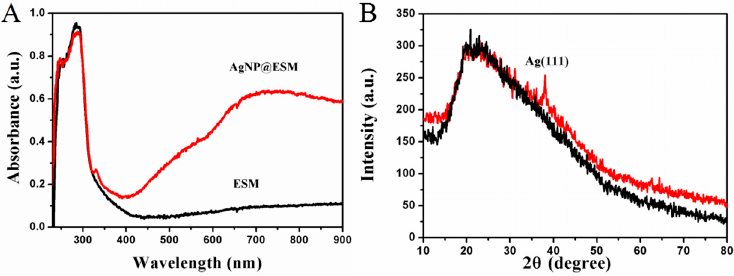
Figure 3. UV-vis diffuse reflectance spectra ( A ) and XRD pattern ( B ) of pristine ESM and AgNP@ESM.